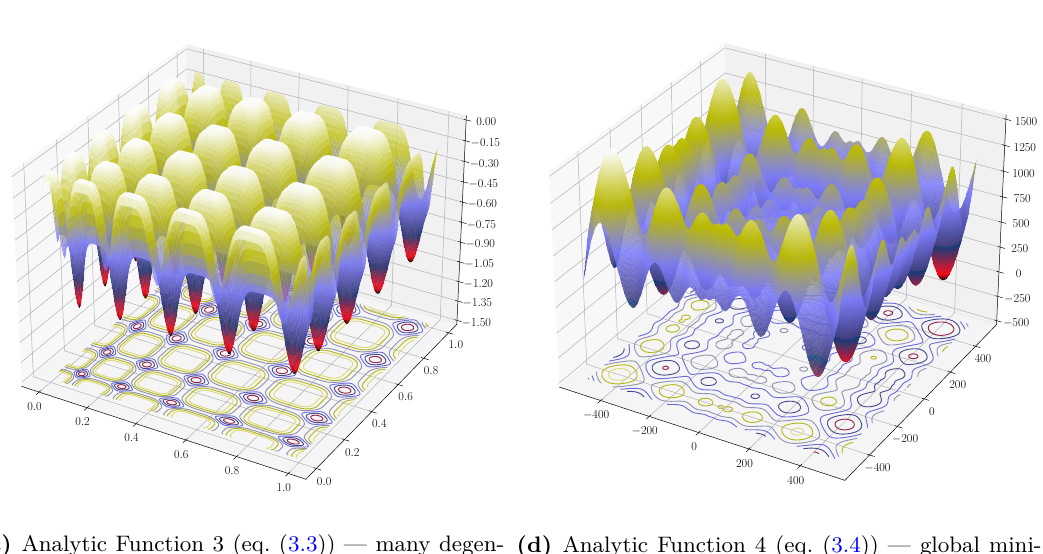
(b) Analytic Function 2 (eq. (3.2)) — global mini- mum at − 0 . 23 .